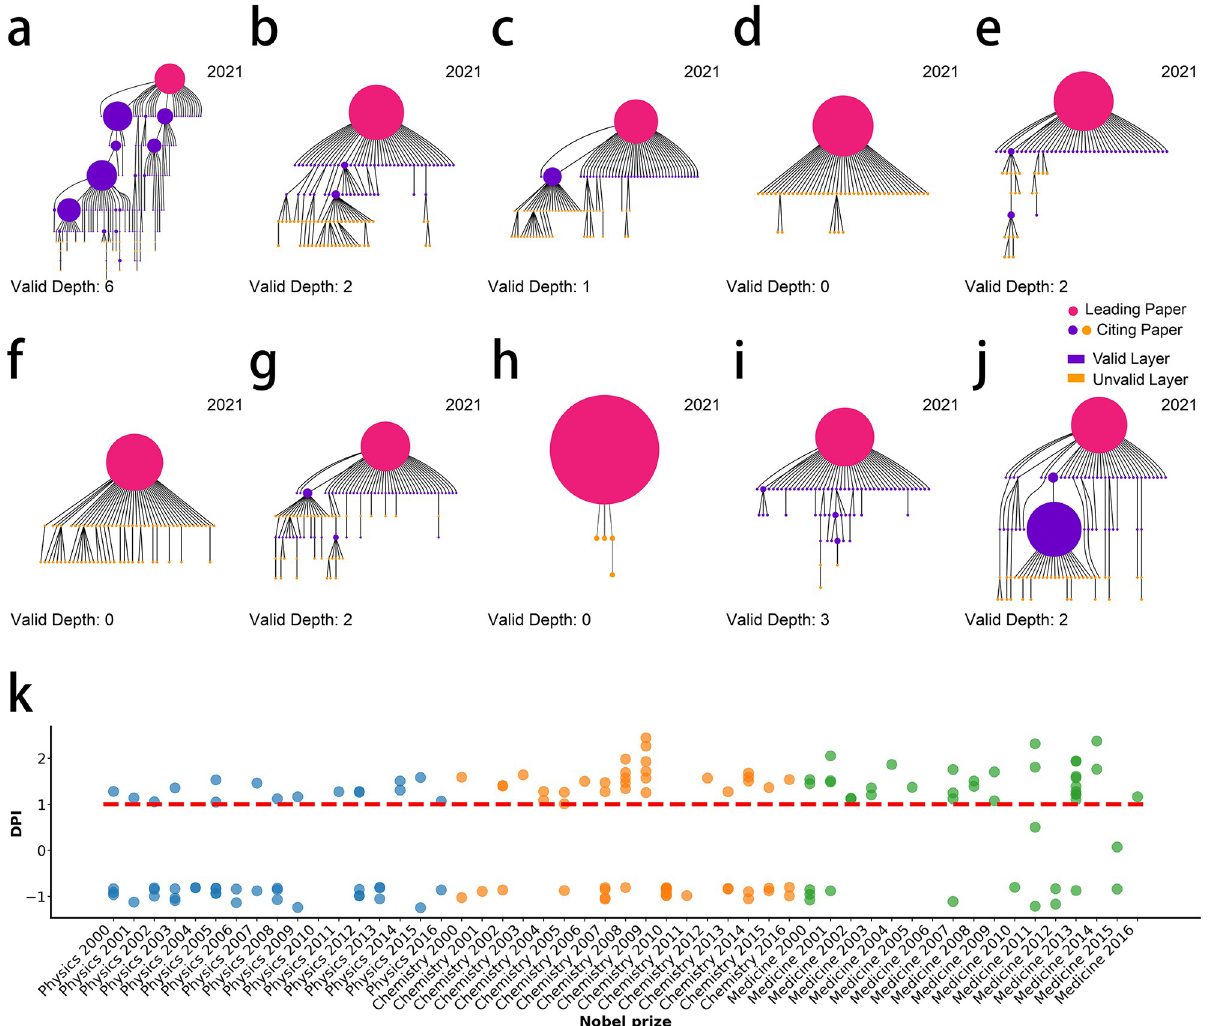
Fig 4. The verification of scientific X-ray’s VD and DPI by prize data. (a) The structure of the idea tree led by ‘A programmable dual-RNA-guided DNA endonuclease in adaptive bacterial immunity’ in 2021 (The Champion of science’s 2015 breakthrough). (b-j) The idea trees of runner-up papers